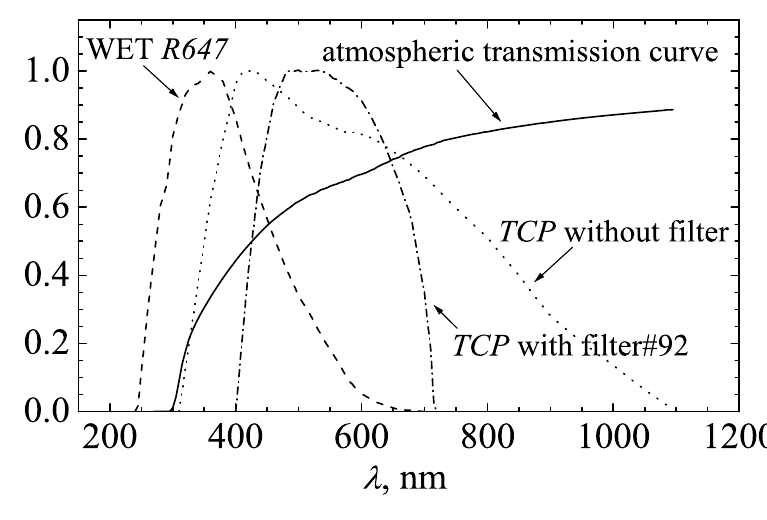
Fig. 2. The atmospheric transmittance curve for the Mol˙etai Ob- servatory (solid line) and the response functions for the Tromsø WET photometers. The dashed line – the WET R647 photometer + two alu- minum surfaces, the dotted line – the TromsøCCD photometer: TE1051 detector + two aluminum surfaces, the dash-dotted line – TE1051 detector + filter #92 + two aluminum surfaces.